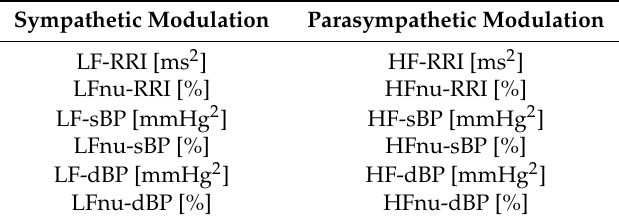
Table 1. Autonomic